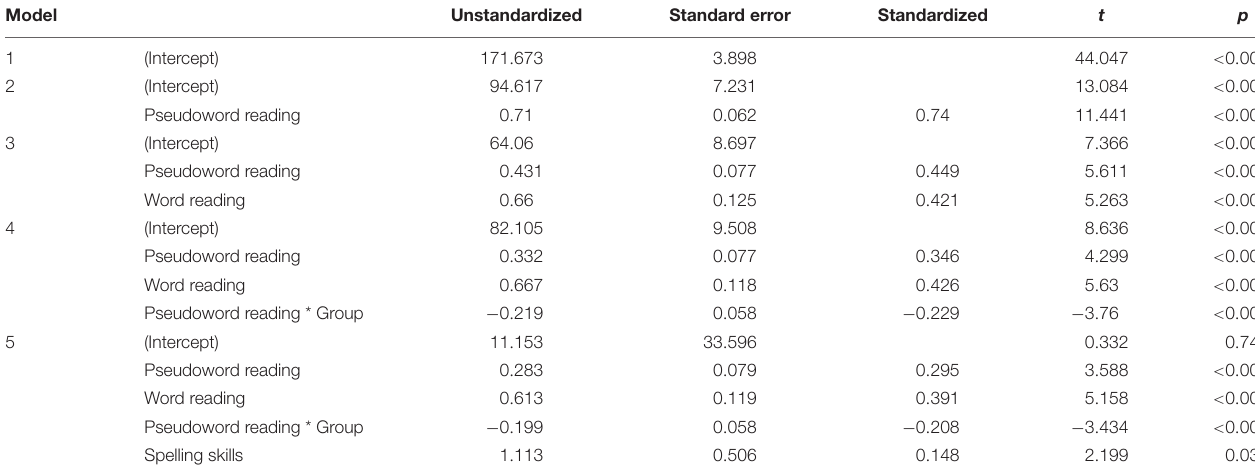
T-values and p-values were obtained from a stepwise regression linear model.